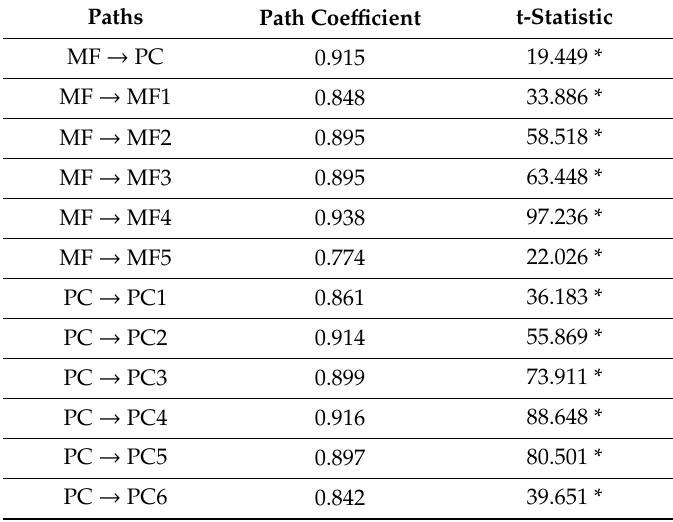
Table 6. Results of path coe ffi cient estimates of the Structural Model.